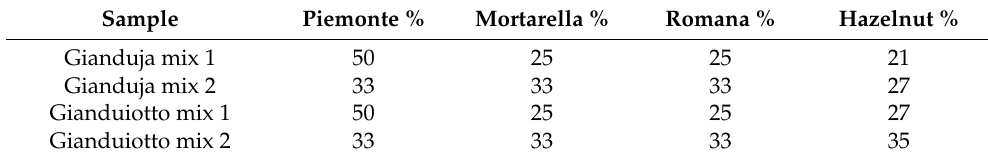
Table 4. Samples of Gianduja and Gianduiotto pastes prepared with mixtures of hazelnuts of known origin. The column “Hazelnuts %” indicates the total amount of hazelnuts in the samples.